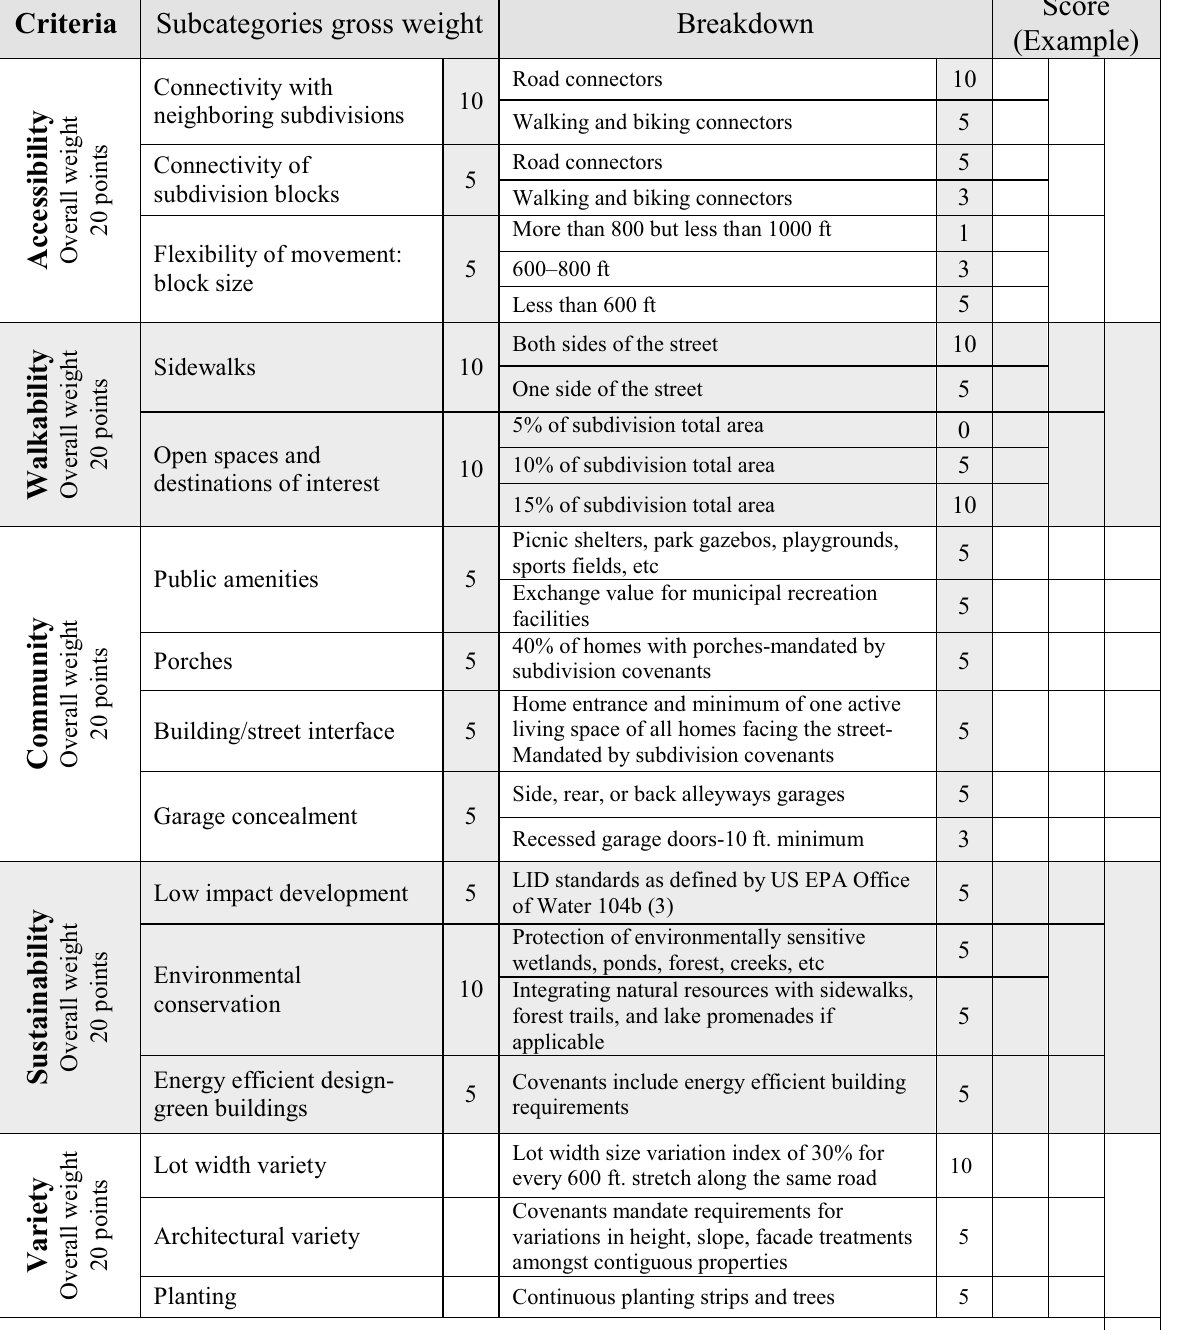
Table 1 The score card used in the preliminary assessment of subdivision applications